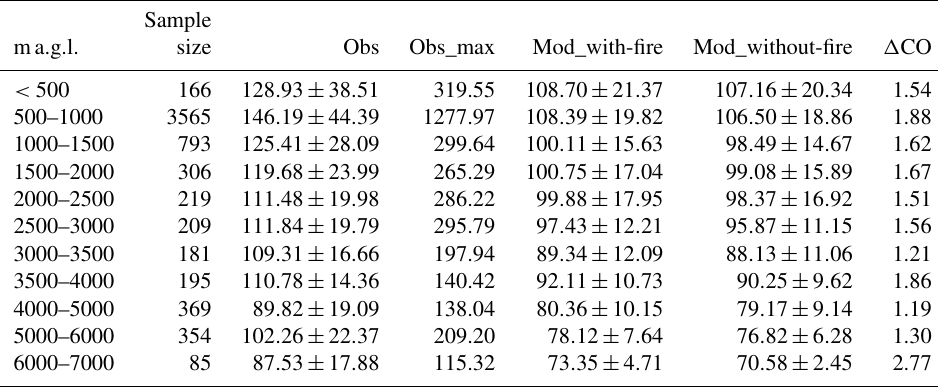
Table 1. Observed and simulated CO (ppb) during NOAA SENEX. Sample